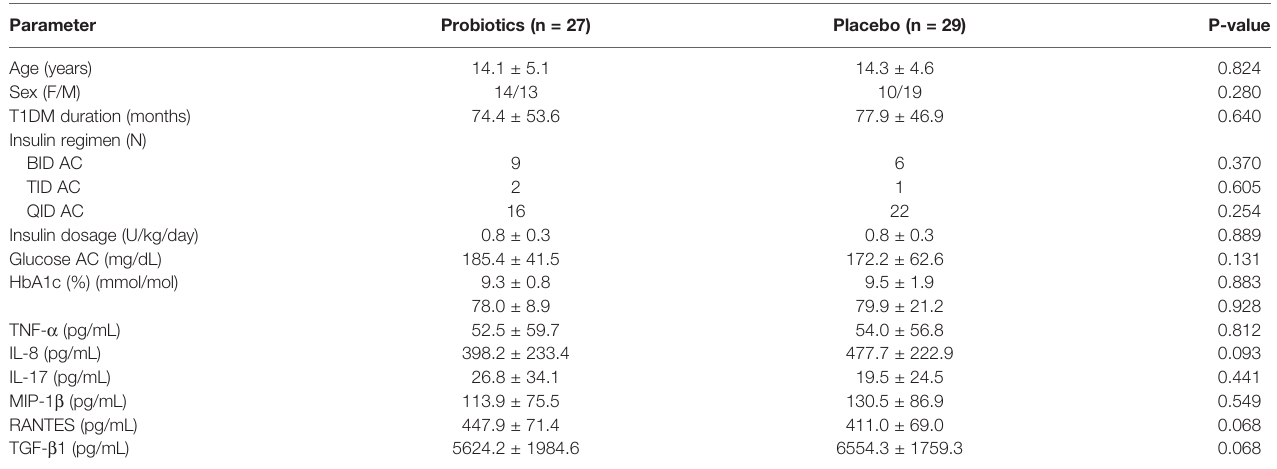
TABLE 1 | Baseline demographic and laboratory characteristics of patients with